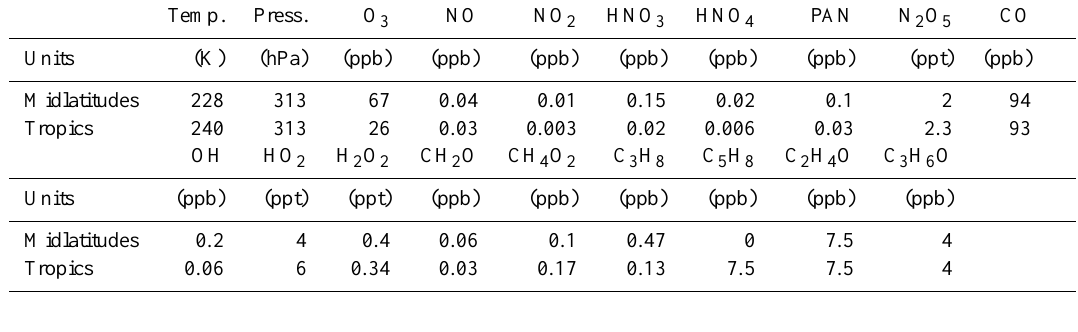
Table 1. The initial atmospheric parameters and background concentrations of chemical species from GEOS-Chem outputs for the DSMACC box model simulations.